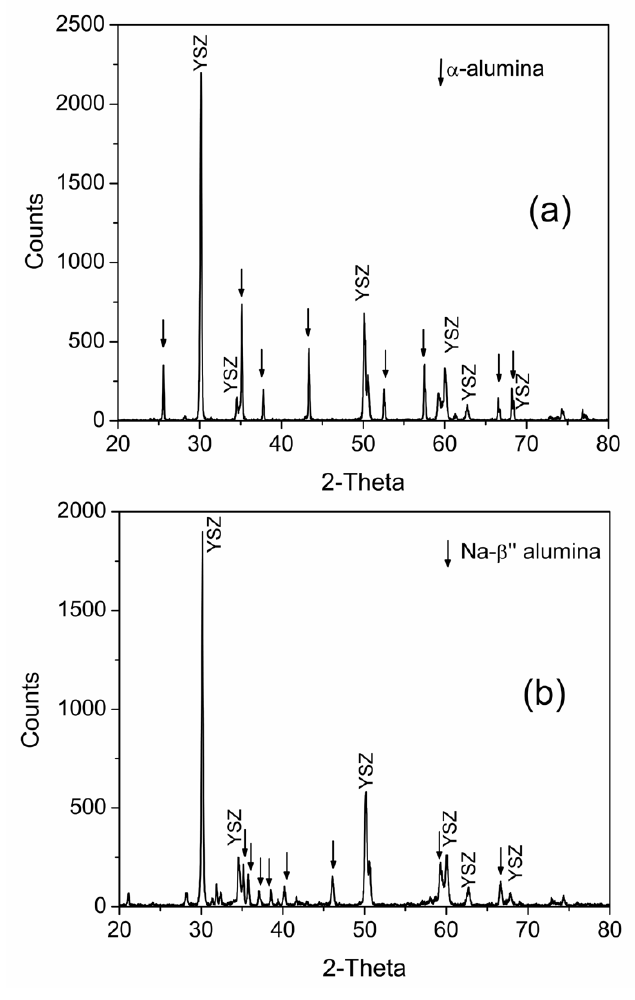
Figure 1. XRD patterns of α -Alumina + YSZ composites ( a ) before and ( b ) after subjecting to vapor phase conversion at 1250 °C.